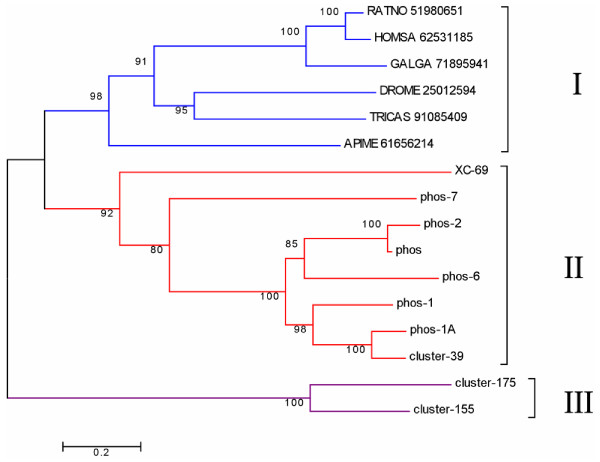
Phylogram of human, rat, chicken, beetle (Triboleum castaneum), fly (Drosophila melanogaster), bee and flea acid phosphatase sequences. The phylogram was deducted from the Clustal alignment from figure 2. The non flea sequences are indicated by 5 letters representing the first 3 letters of the genus and 2 letters of the species name, followed by the NCBI accession number. The numbers in the phylogram indicates the percentage of concordance in 10,000 bootstraps. The bar at the bottom indicates 20% amino acid distance.